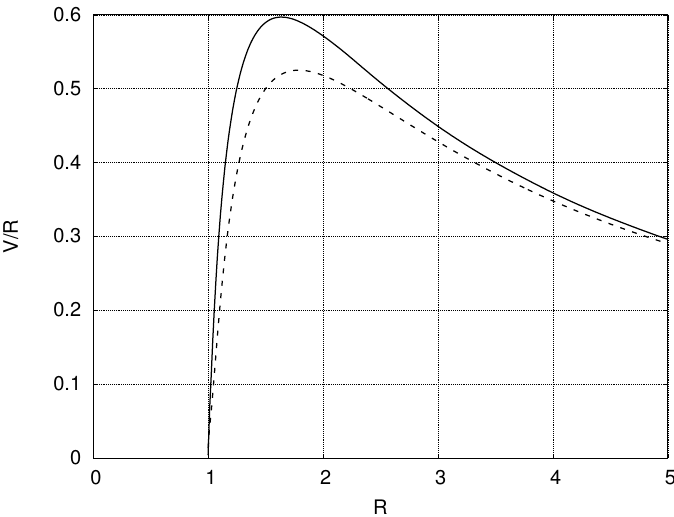
Figure 1. Dependence of the ratio V on R at v 2 s = 8 × 10 − 3 (solid line) and v 2 s = 2 × 10 − 2 (dashed R line). All the geometrical values are expressed in units of radius of the star at the pole R pole . Velocity is expressed in Kepler velocity at the